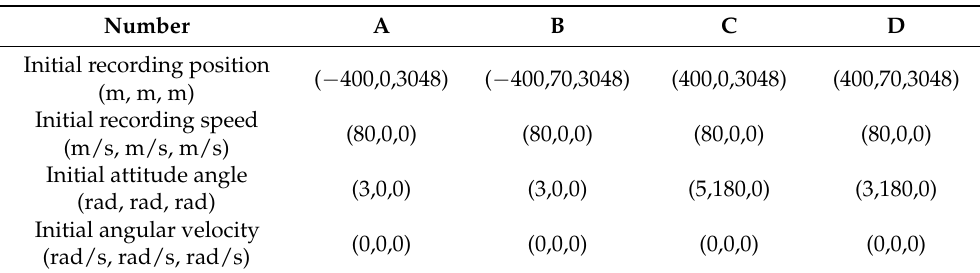
Table 7. Initial state.